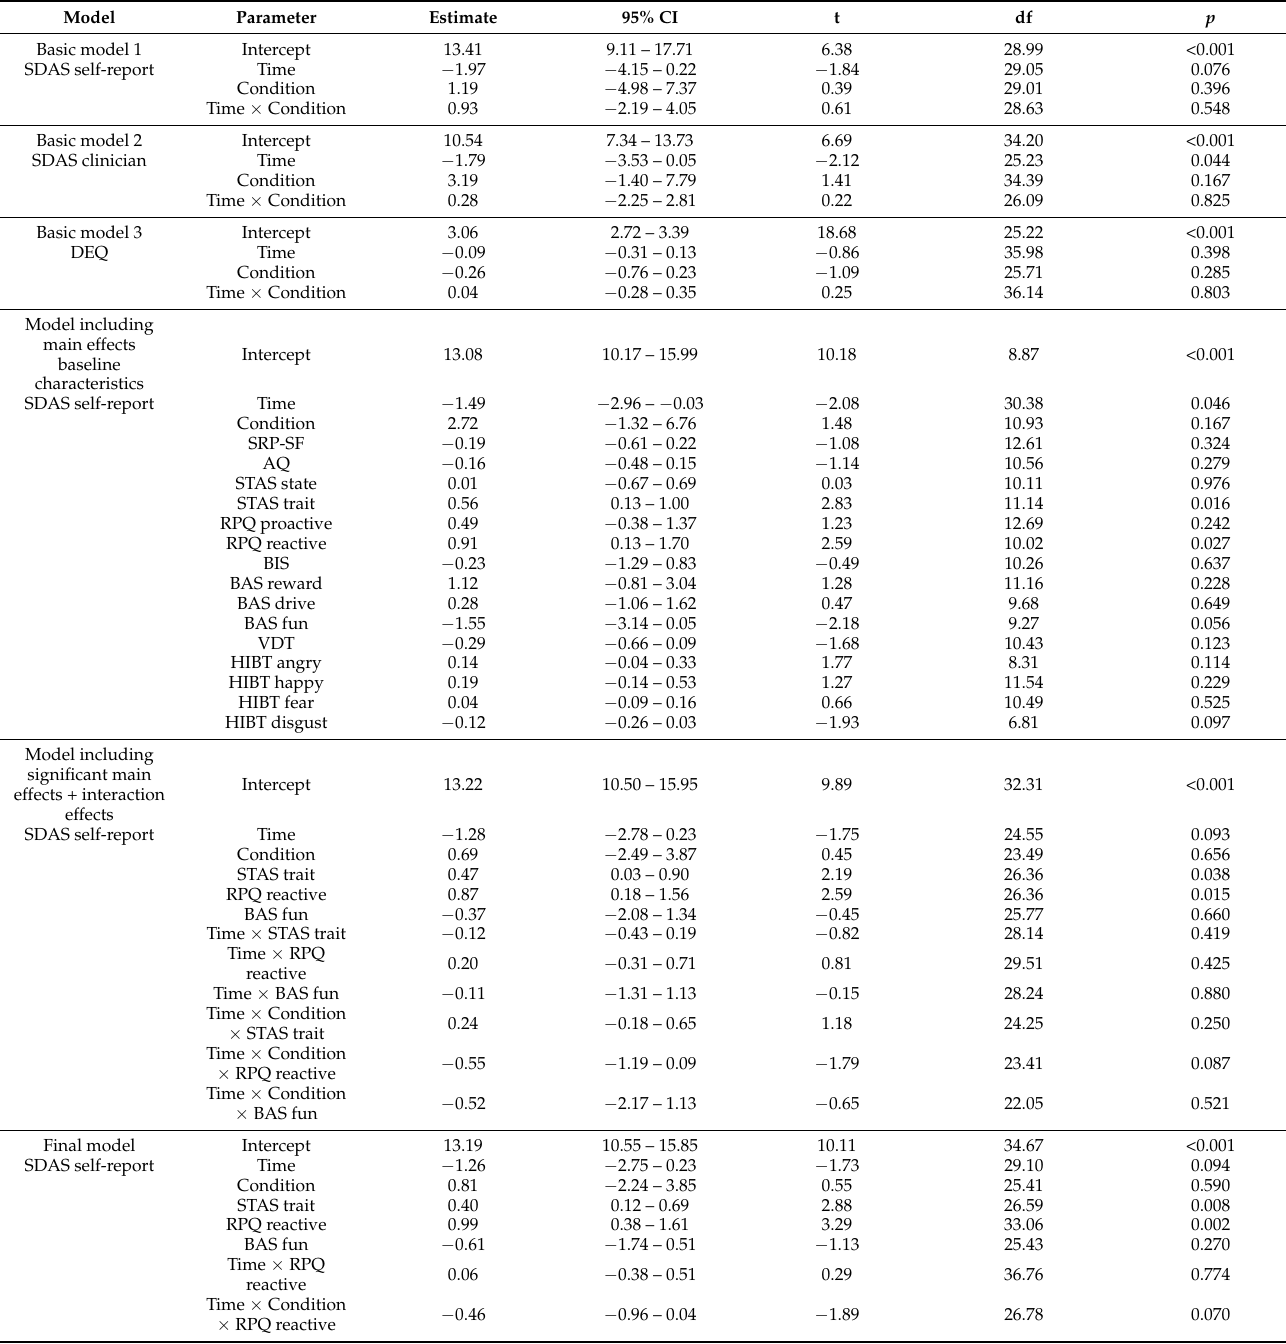
Table 4. Results of linear mixed